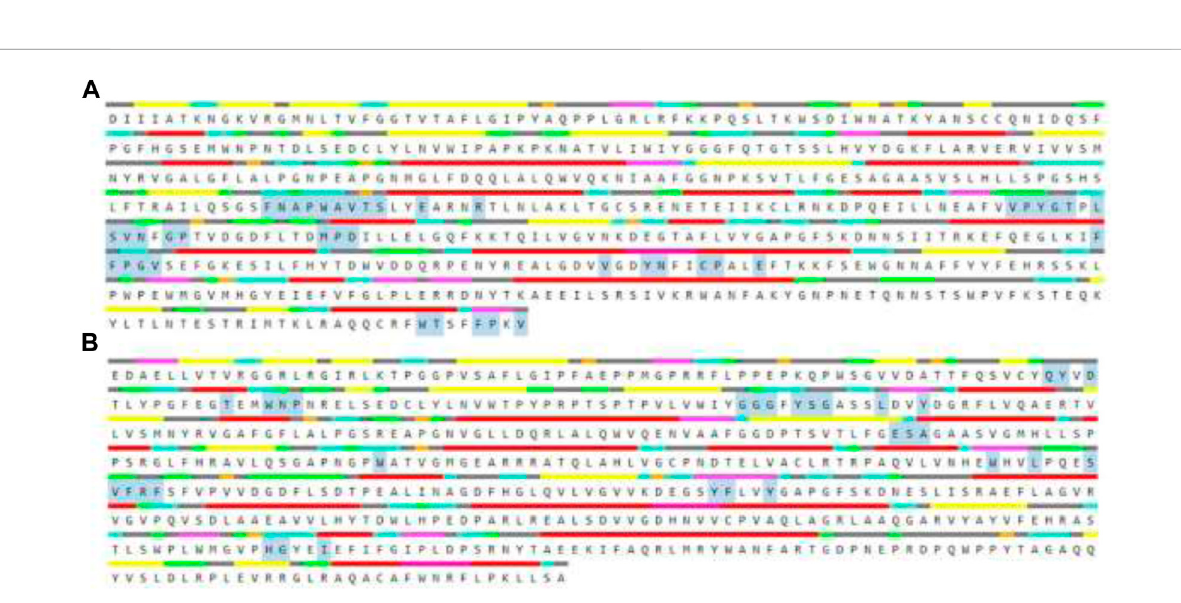
FIGURE 7 The amino acid residues highlighted in grey speci fi es the binding pocket of the selected receptors (A) BChE (4AQD) and (B) AChE (4EY7).